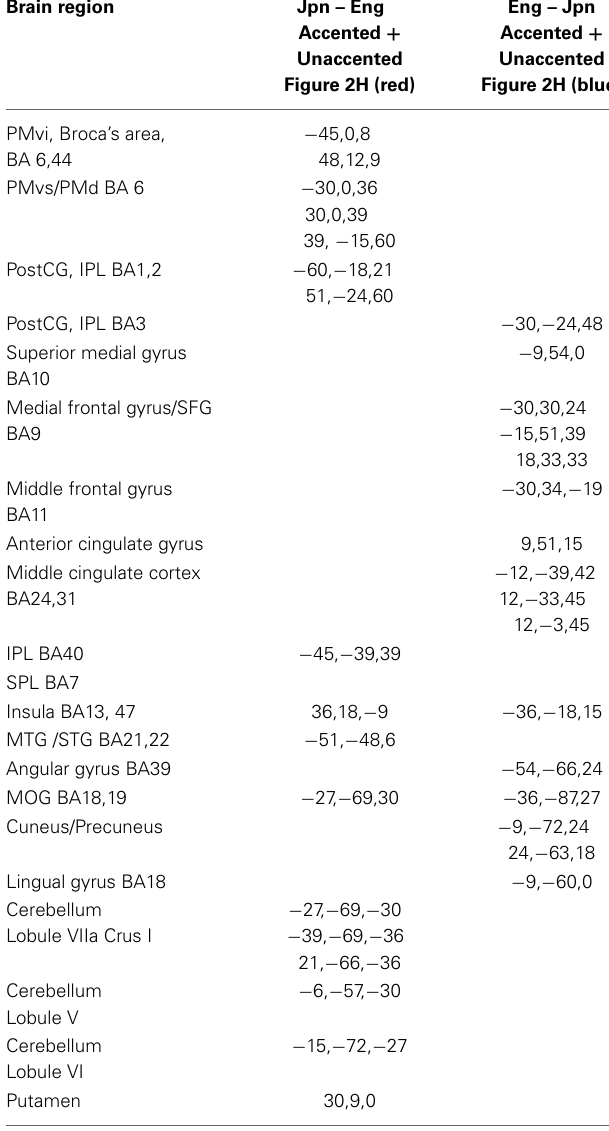
Table 1 | Conjunction of all conditions Eng Unaccented, Jpn Unaccented, Eng Accented, Jpn Accented (Figure 2G).